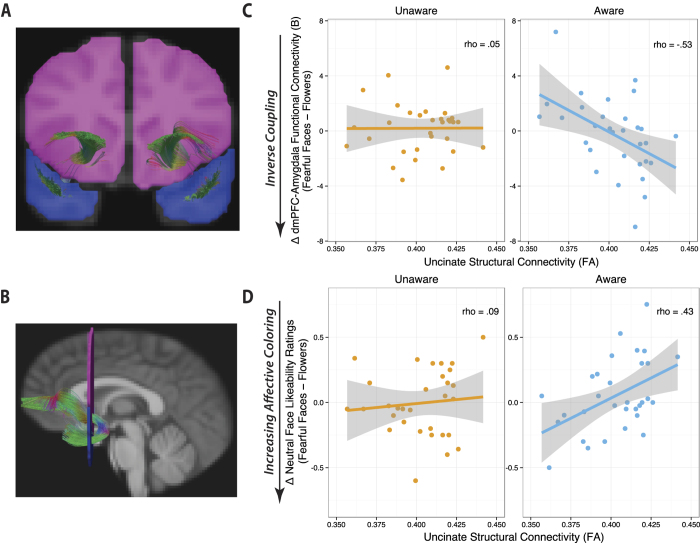
(A) Placement of temporal and frontal waypoint regions of interest used to identify the uncinate fasciculus is shown for a representative subject. The Boolean AND operation was used to select only the fibers that crossed through both the temporal and frontal waypoint regions of interest. (B) The left uncinate fasciculus from a representative subject is shown, overlaid on the average normalized T1 images across all subjects. When individuals were aware of the emotional stimuli [fearful faces – flowers], greater left uncinate fasciculus FA was associated with (C) more inverse amygdala-dmPFC coupling, p < 0.01 and (D) less affective coloring of novel neutral faces, p = 0.014.